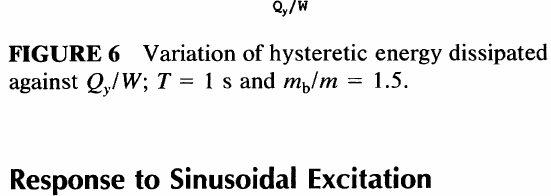
FIGURE 4 Variation of hysteretic energy dissipated against time period of superstructure; mbl m = 1.5 and Q/W = 0.08.